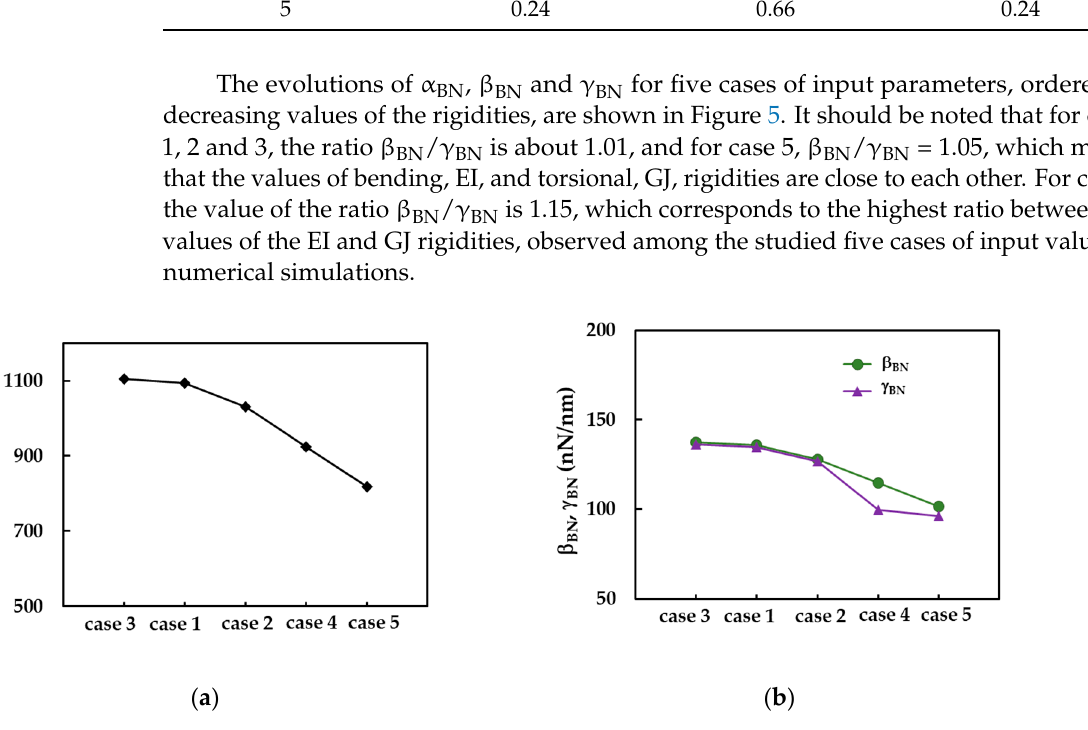
and γ fitting parameters for the five cases of input values in the BN BN